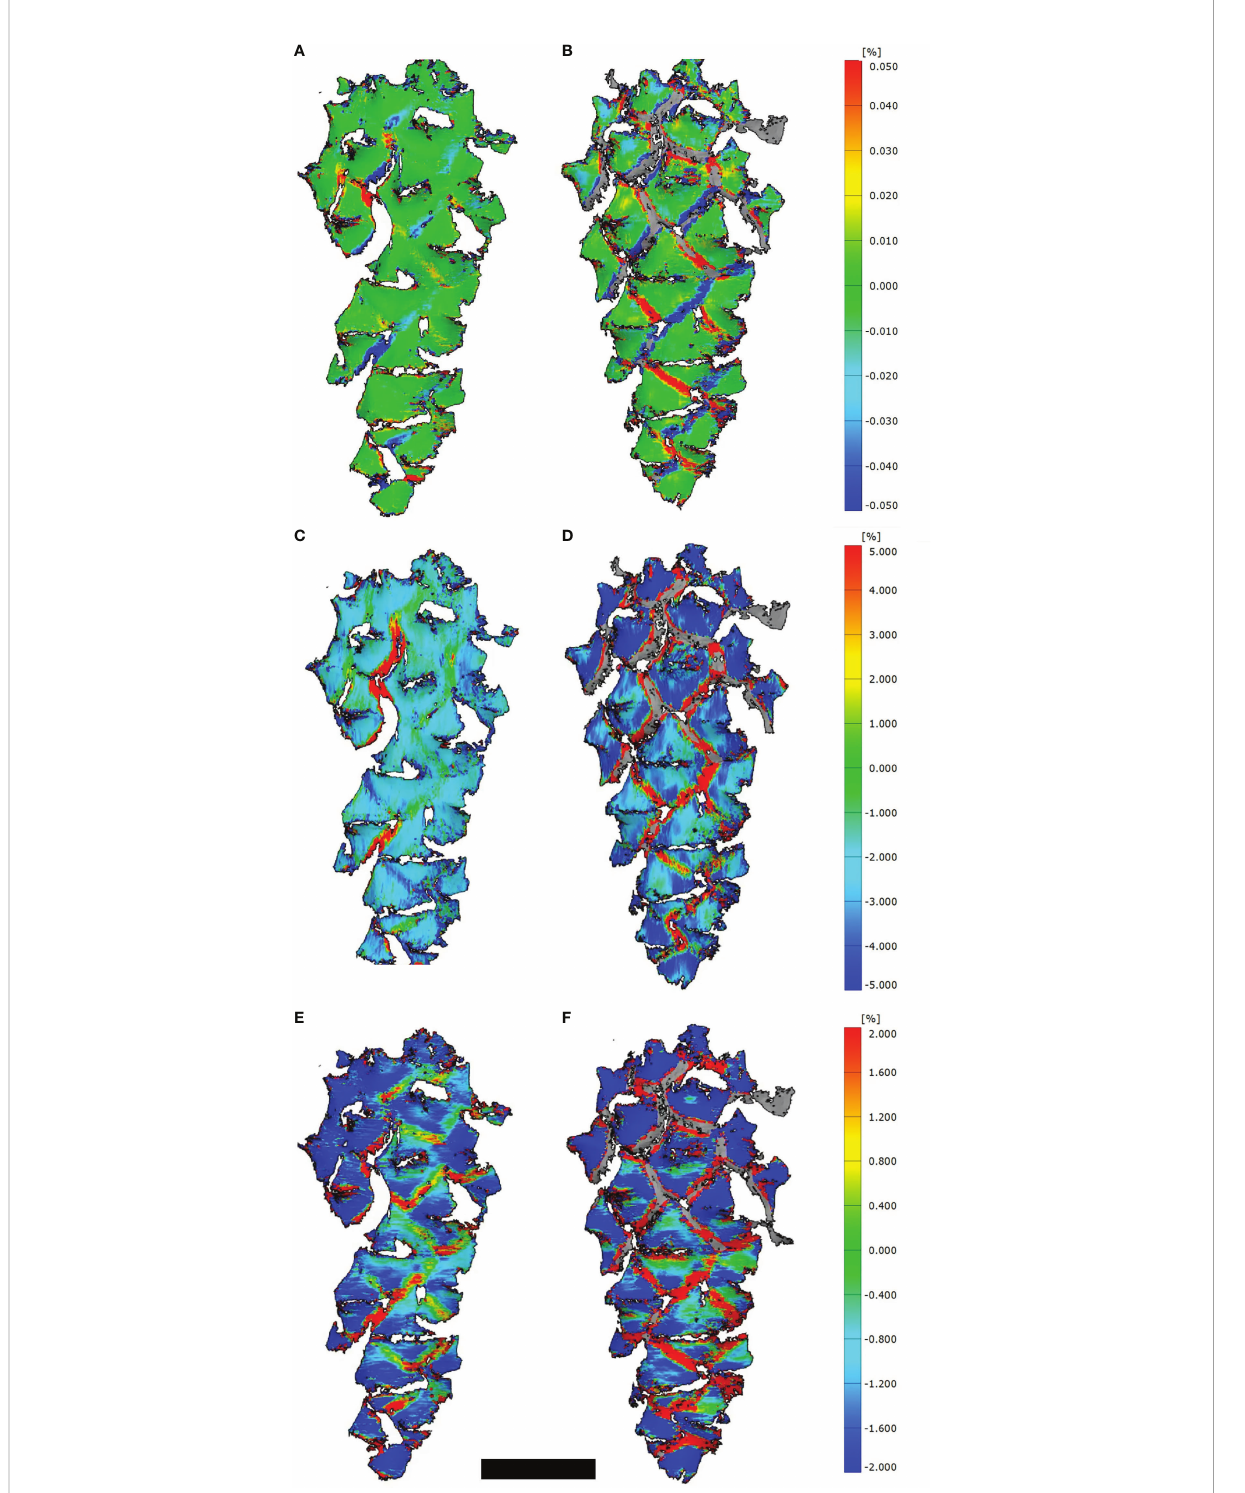
FIGURE 2 3D-DIC analyses of opening cones. (A, C, E) Strains on the cone surfaces during initial opening (t=400 min) and (B, D, F) during secondary opening (t=225 min). Given are strains combined for the longitudinal as well as transversal direction (A, B) , strains in transversal (C, D) and longitudinal direction (E, F) . Note the stochastic occurrence and development of strains at the border regions between scales during the initial opening, compared to the regular pattern during the secondary opening. Scale bar = 1